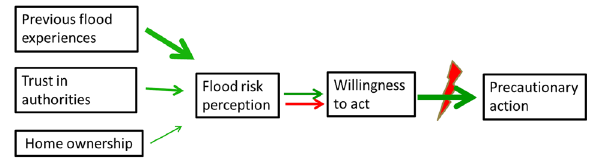
Fig. 1 Visualization of the gap between flood risk perception and flood precautionary action. Source : Adapted from Wachinger et al.